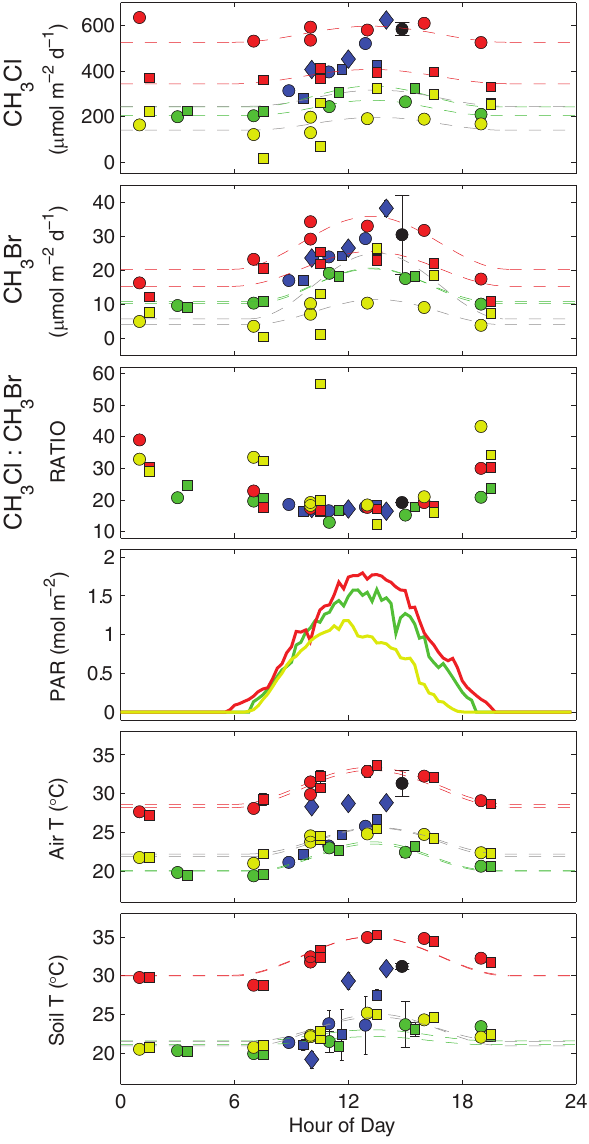
Figure 2. Net fluxes of CH 3 Cl, net fluxes of CH 3 Br, the CH 3 Cl to CH 3 Br flux ratio, photosynthetically active radiation (PAR), cham- ber air temperature and surface soil temperature at B. maritima sites versus time of day (central standard time). Colors represent differ- ent outings, as in Fig. 1; different symbols (circles, squares, dia- monds) represent different sites at the same outing. Error bars that are smaller than the symbols are not shown. The dashed lines repre- sents the model fit to TX3-5 (March, July, and November) results. PAR is a 15min interval measurement averaged over the 2 days of each field outing.